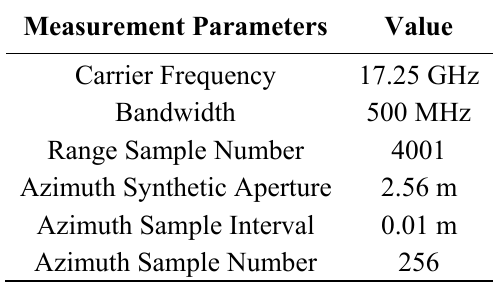
Table 1. Measurement parameters used in the